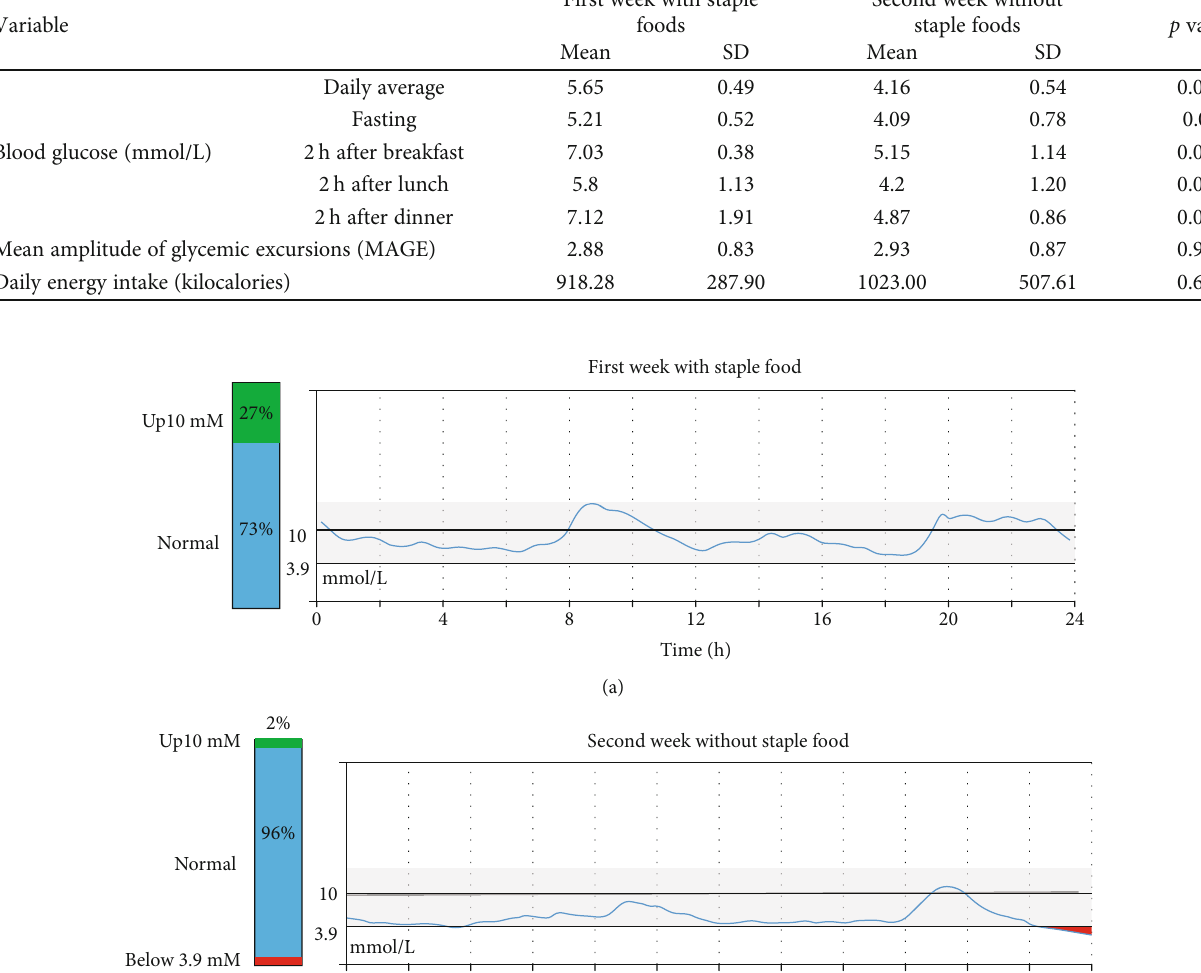
Table 3: The mean and standard deviation of blood glucose and daily energy intake of the proband between the two weeks. Variable